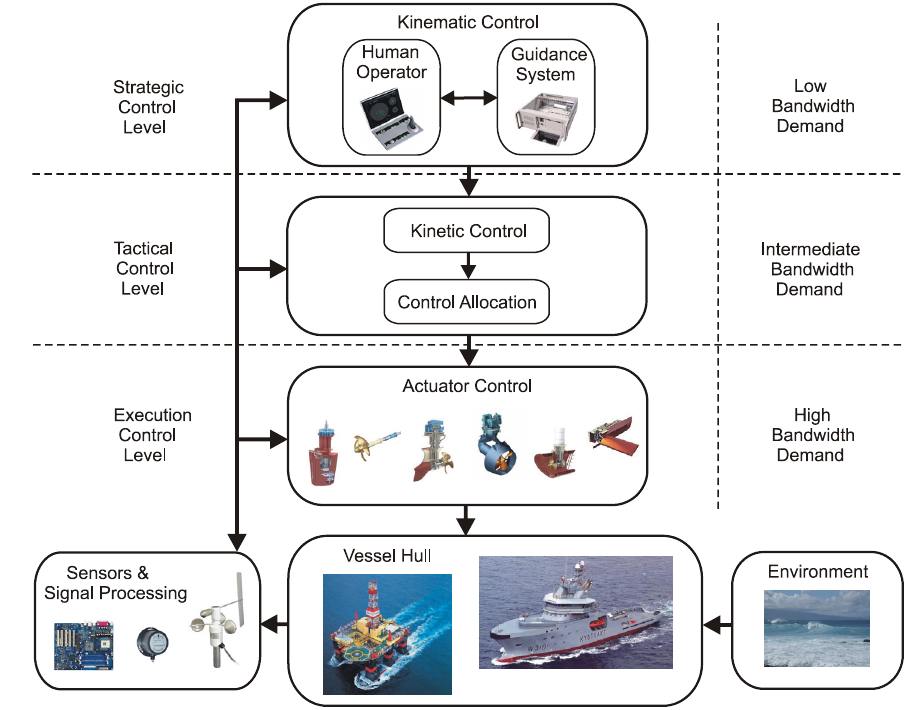
Figure 2: The motion control hierarchy of a marine surface vessel nominally consists of strategic, tactical, and execution levels of control. Additional levels are required to achieve full